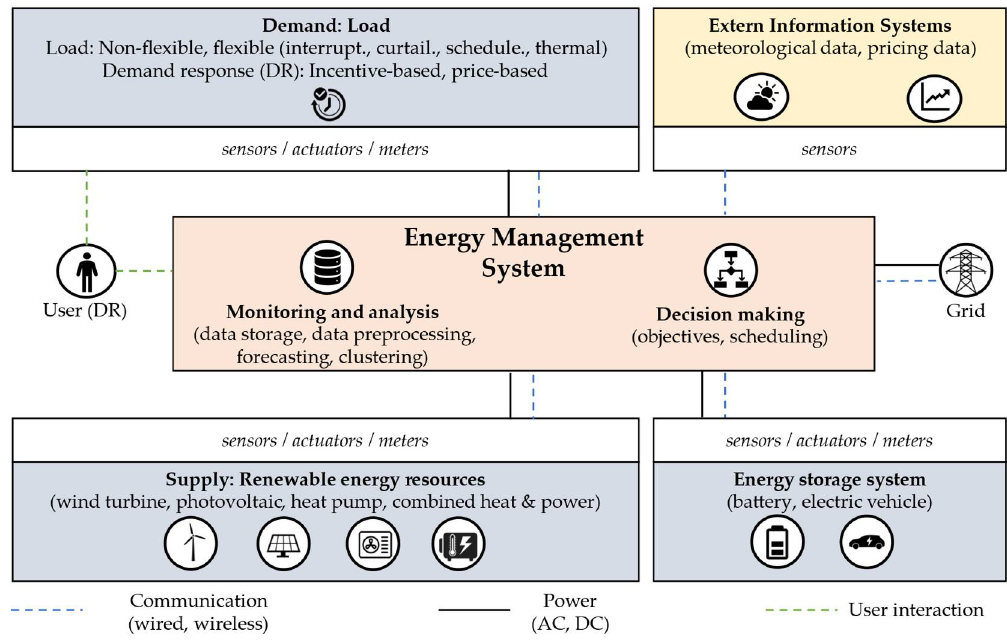
Figure 2. A modular design of an energy management system infrastructure .